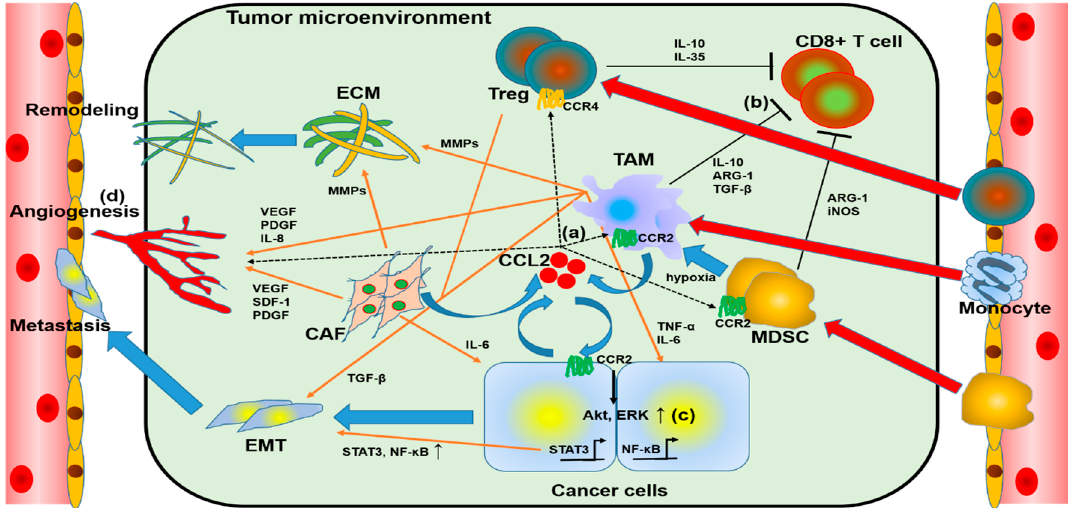
Figure 1. Overview of chemokine (C-C motif) ligand 2 (CCL2) and the tumor microenvironment (TME). ( a ) Cancer-cell- derived CCL2 acts on regulatory T cells (Tregs), tumor-associated macrophages (TAMs), and myeloid-derived suppressor cells (MDSCs) and recruits these to the TME. ( b ) Tregs, TAMs, and MDSCs reduce anticancer immunity by suppressing CD8+ lymphocytes. ( c ) Autocrine, TAM, and cancer-related fibroblast (CAF)-derived CCL2 induces epithelial–mesenchymal transition (EMT) in cancer cells to promote metastasis. ( d ) Factors from cells that occupy the TME enhance angiogenesis and extracellular matrix (ECM) remodeling, assisting tumor growth and metastasis.